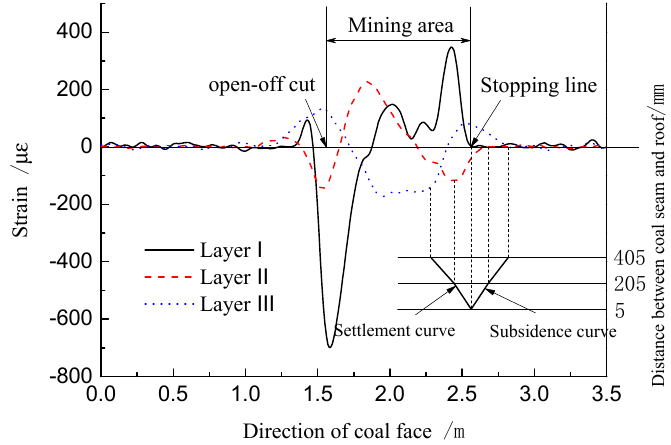
Figure 8. Vertical strain distribution of overburden strata.